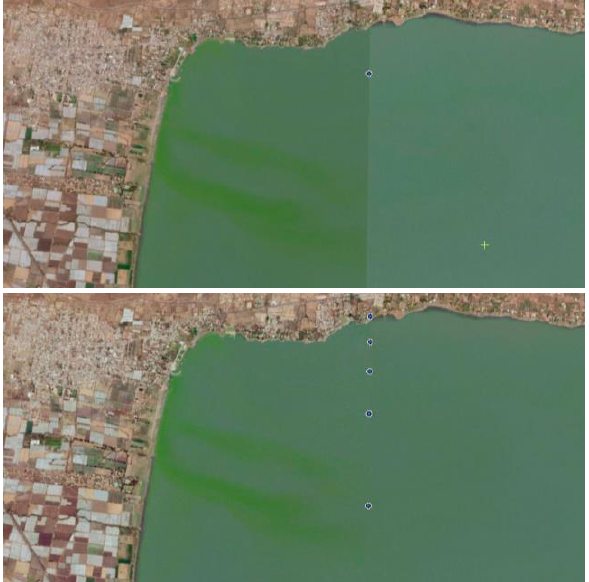
Figure 1. Detail of Lake Chapala, before (above) and after (below) manual dodging; dodging points as white circles